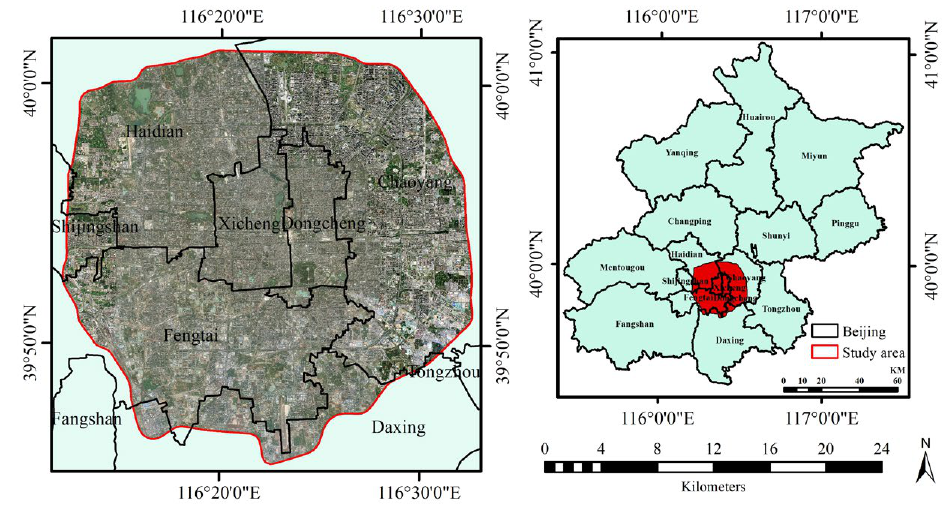
Figure 1. The study area, within the Fifth Ring Road of Beijing, includes the city’s urban area. In the context of increasingly prominent urban diseases in China, in recent years,